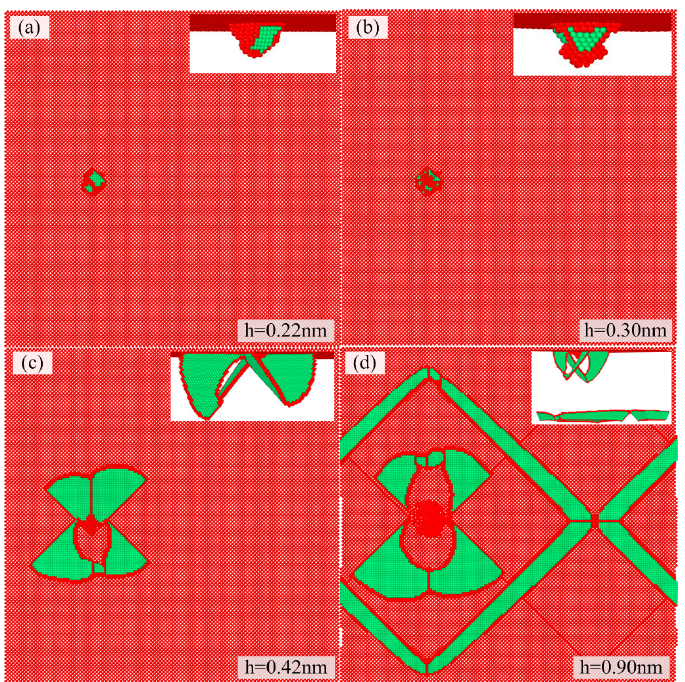
Figure 11. Atom configuration during indentation process with residual tensile stress λ = 0.30 at various indentation depths: ( a ) 0.22 nm; ( b ) 0.30 nm; ( c ) 0.42 nm; ( d ) 0.90 nm. The green color shows stacking faults.